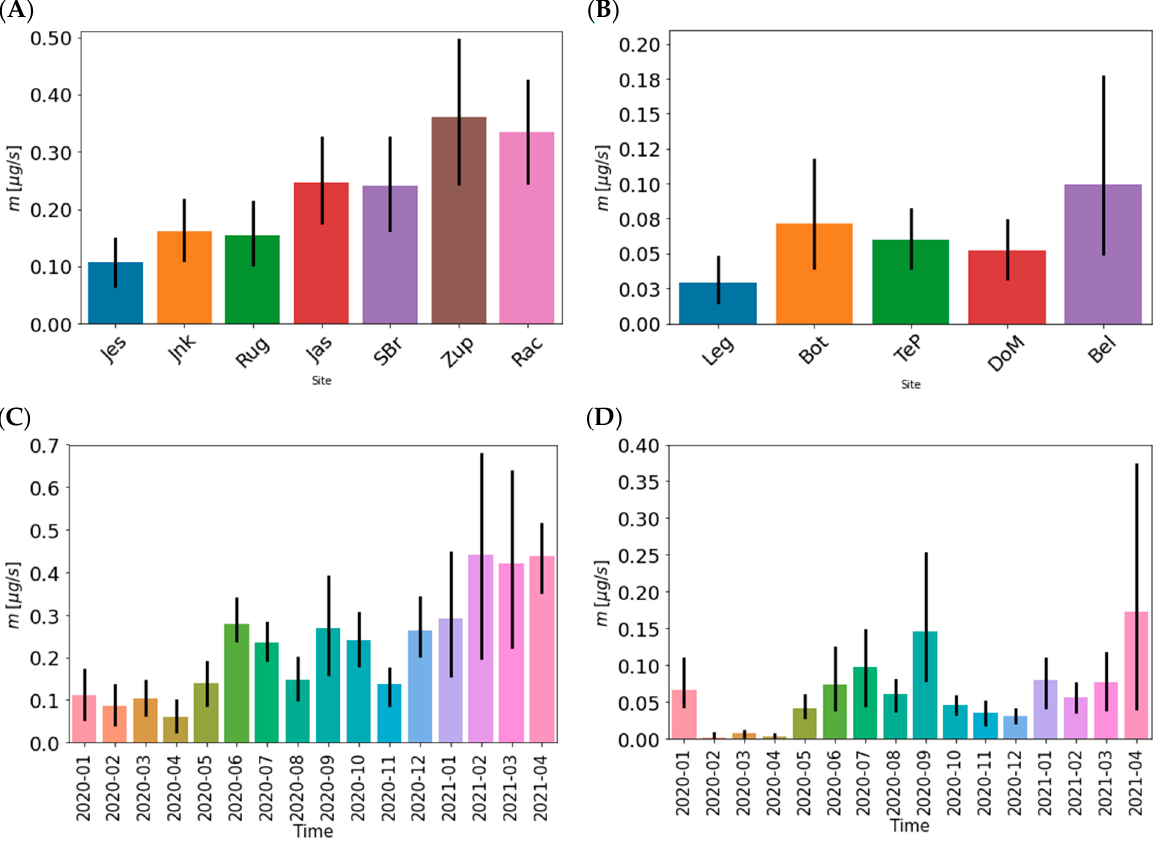
Figure 2. Average PhACs/IDrgs mass flow over the analyzed period of 16 months across all sites in ( A ) Sava River and ( B ) Drava River. Average PhACs/IDrgs mass flow over time and sites for ( C ) Sava River and ( D ) Drava